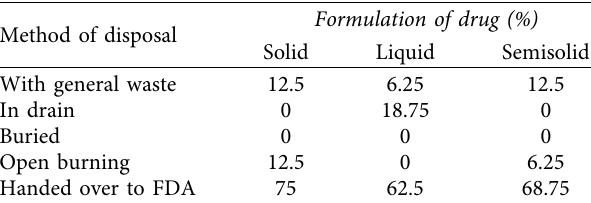
Table 1: Disposal methods used by pharmacies located within the Krowor municipality ( n �